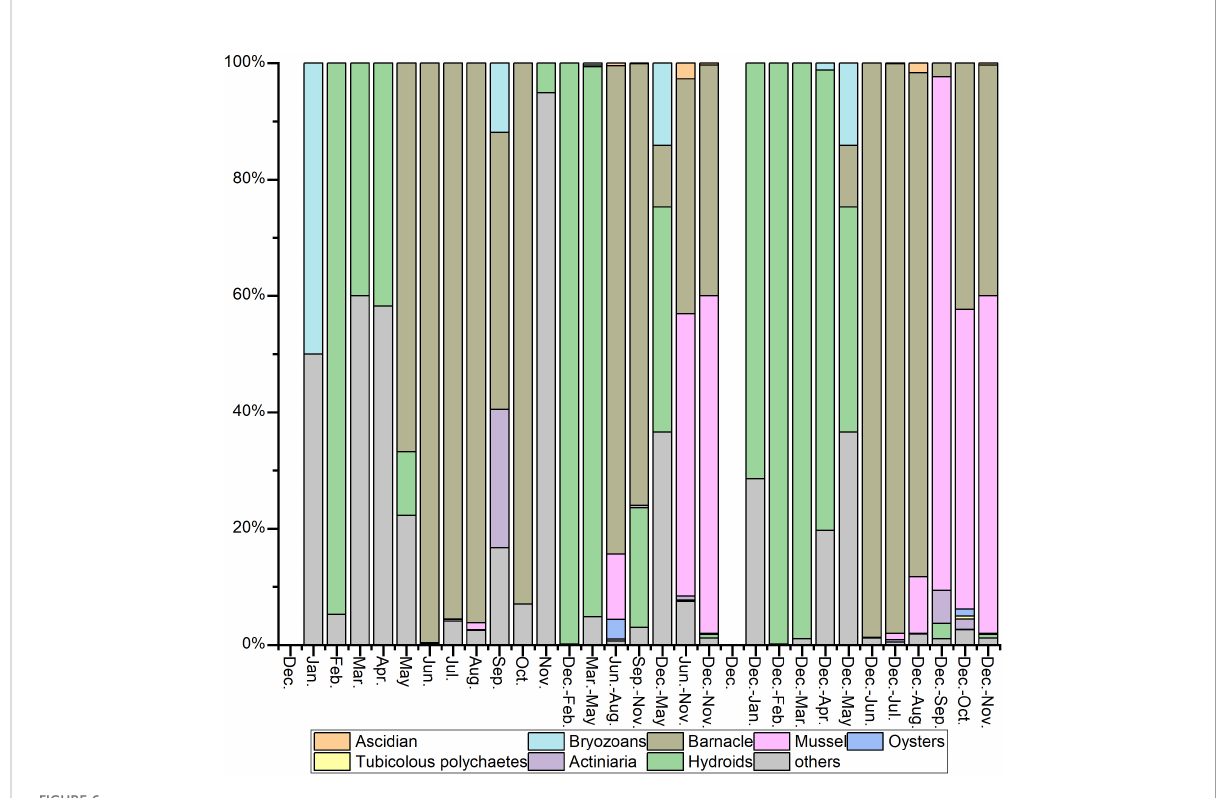
FIGURE 6 Biomass composition of the bottom test panels MTPs and